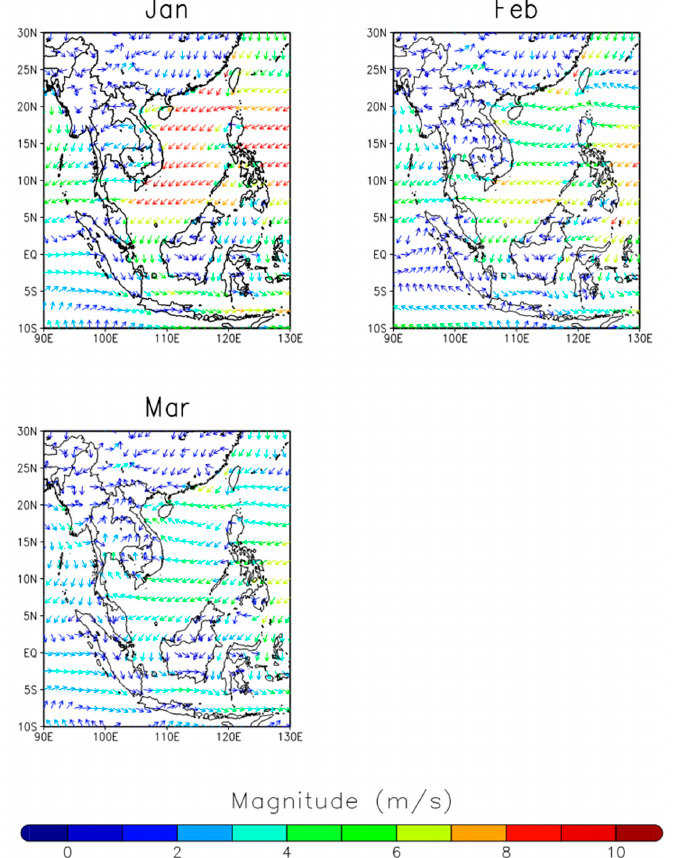
Figure 2. Synoptic wind flow using 10 m u- and v-components of wind vector from January 2019 until March 2019.